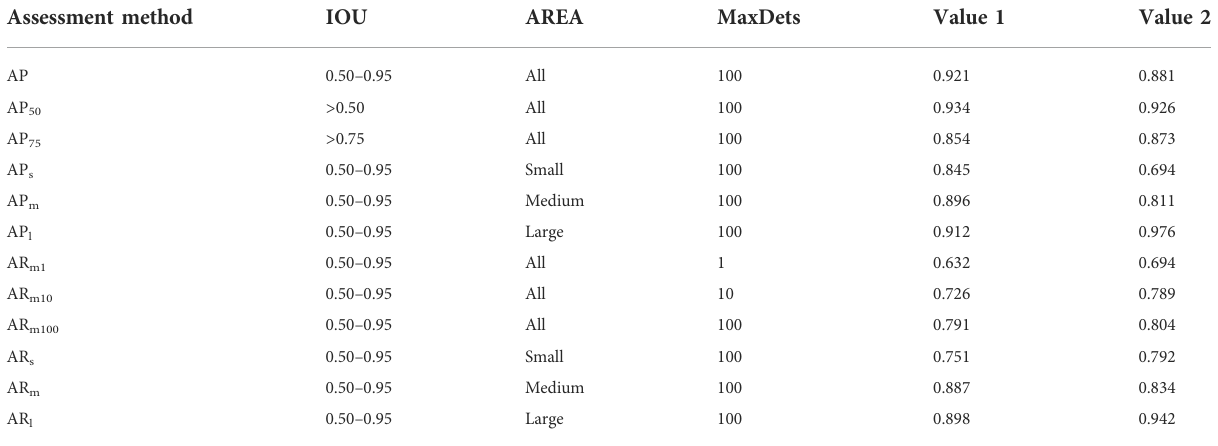
TABLE 1 Index values of different assessment methods. Assessment